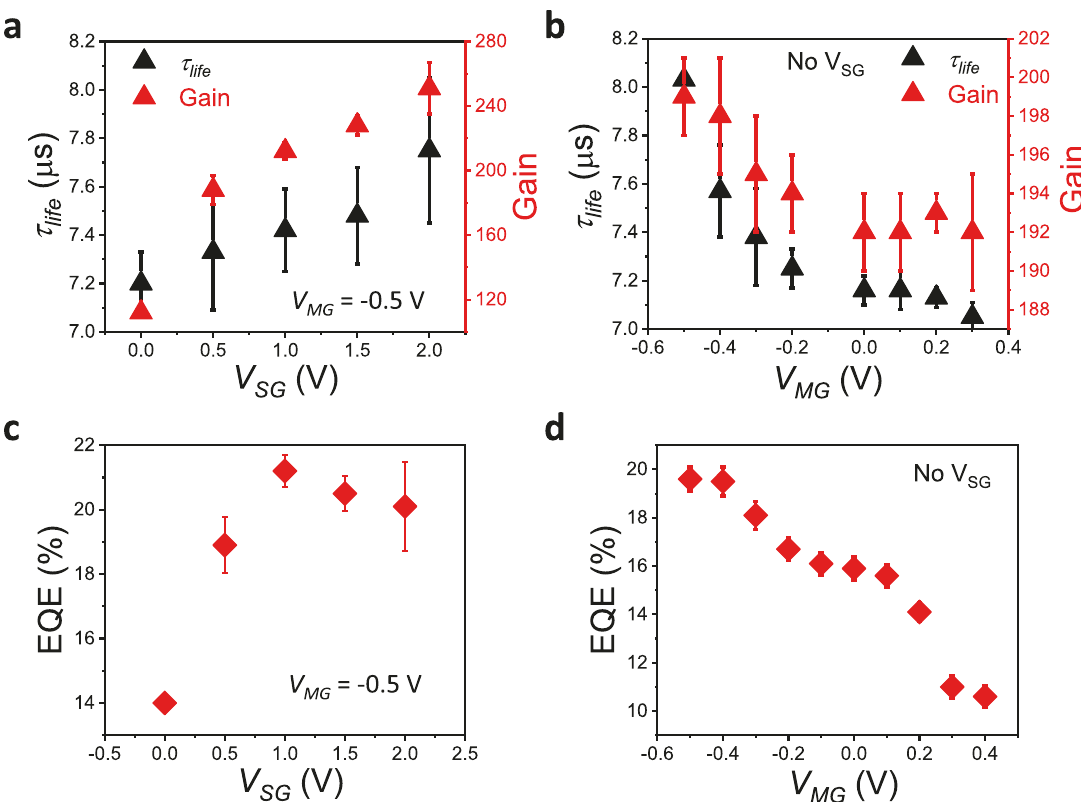
Fig. 5 Gate voltage dependence of gain, carrier lifetime and EQE of WSe 2 phototransistor. a Carrier lifetimes ( τ life ) extracted from photoconductive decay fi ts and calculated photoconductive gain ( G ) are plotted against V SG for fi xed V MG = − 0.5 V. Minority electron ejection from and majority hole injection into the S/D channel under n S – p M – n S con fi guration increases e-h recombination time thereby increasing τ life and G (nearly 2x) vs the p S – p M – p S case. b τ life and G vs V MG , without V SG . The increase in G is much smaller compared to the increase seen for varying V SG , for nearly the same change in τ life . c EQE vs V SG for V MG = − 0.5 V. d EQE vs V MG without V SG . Maximum EQE of 21.5 % is obtained for V SG = 1 V, V MG = − 0.5 V. The error bars indicate variability (s.e) in photoswitching